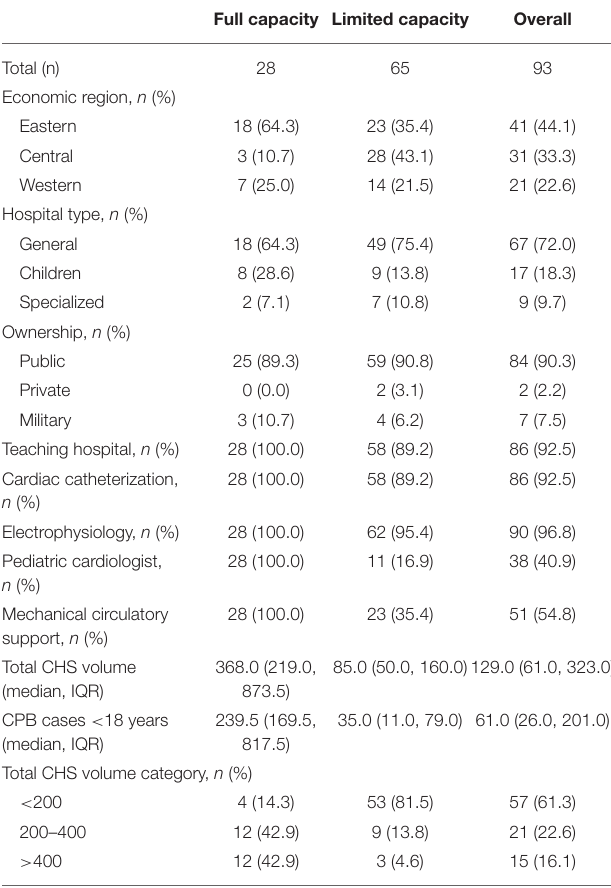
TABLE 2 | Characteristics of care facilities for CHS in northern